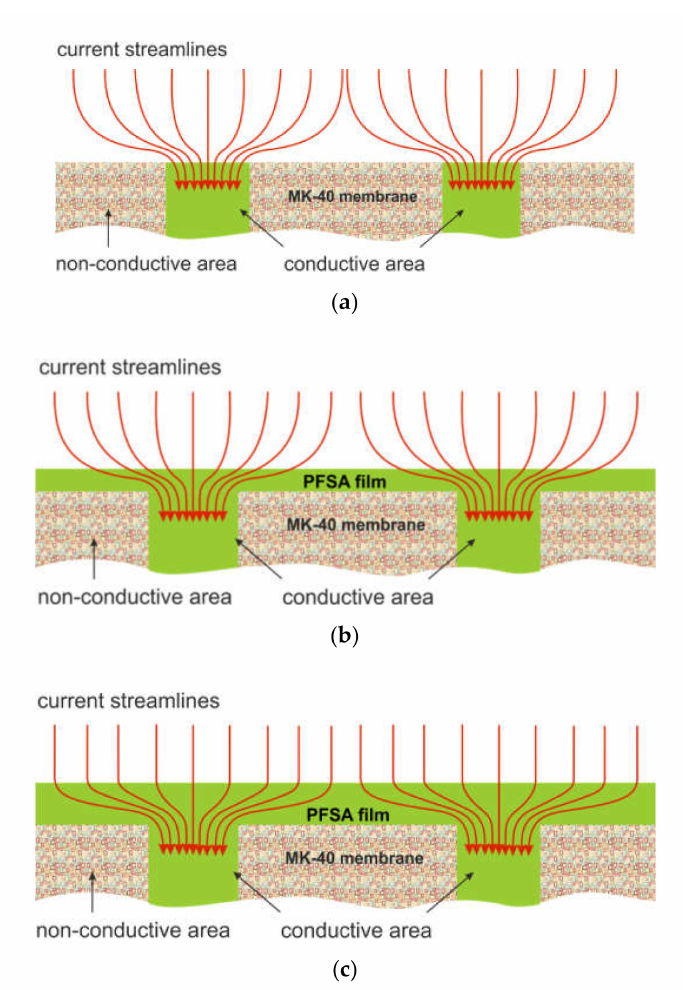
Figure 5. Schematic representation of streamlines near the surface of the MK-40 ( a ) membrane and that, modified by PFSA polymer film of various thicknesses: about 20 µ m ( b ) and about 30 µ m ( c